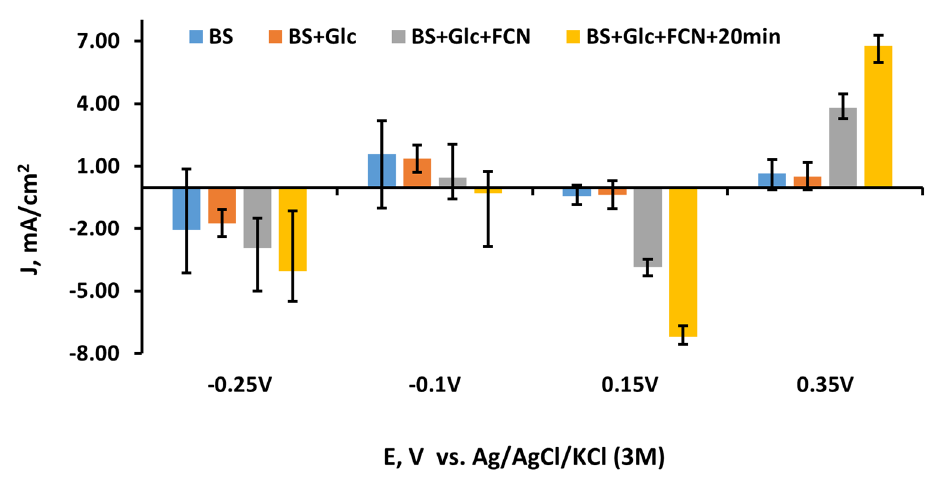
Figure 6. Data from replicated experiments with the MD and yeast-modified electrode.